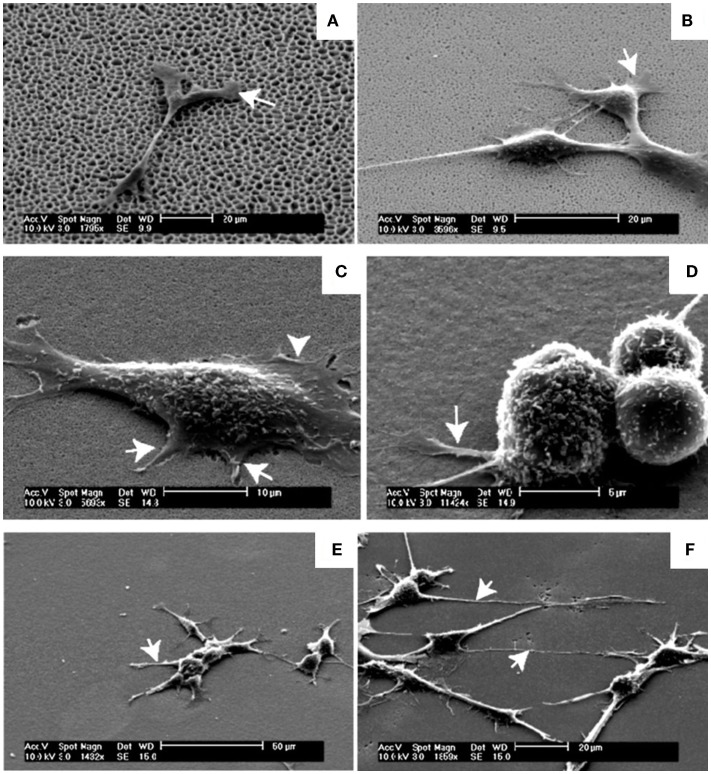
Neuroblastoma cells growth on the graded PSi observed in SEM after 24 h-incubation time. (A) SEM of neuroblastoma cells on the 1000–3000 nm region, arrow depicting the flattening of the lamellipodia serving as anchorage points. (B) The 300–1000 nm region, arrows highlighting the flattening of the lamellipodia closer to the main cell body. (C) The 100–300 nm region, shorter filopodia-like protrusions between 2 and 4 μm as indicated by the arrows while the arrowhead shows the lamellipodia. (D) Spherical neuroblastoma cells adhering on the 50–100 nm pore size region with relatively short and thick filopodia at the base. (E) The 20–50 nm region, initial recovery of the formation of neuritic processes as indicated by the arrow. (F) The 5–20 nm region, processes were long, spanning up to 40 μm from the cell body with significant outgrowth of filopodia as denoted by the arrows. Reprinted from Khung et al. (2008).